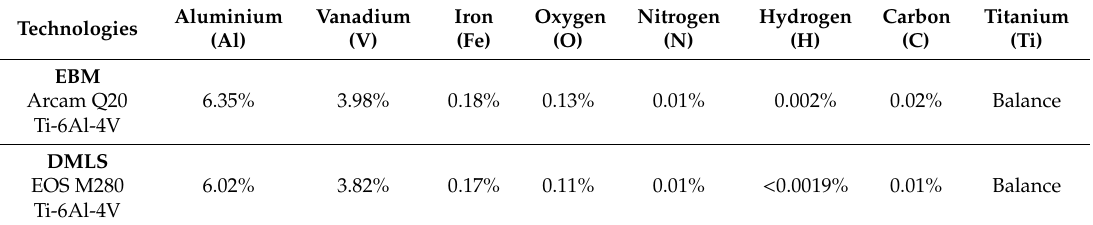
Table 2. Chemical composition of Ti-6Al-4V powders used in the EBM and DMLS processes.